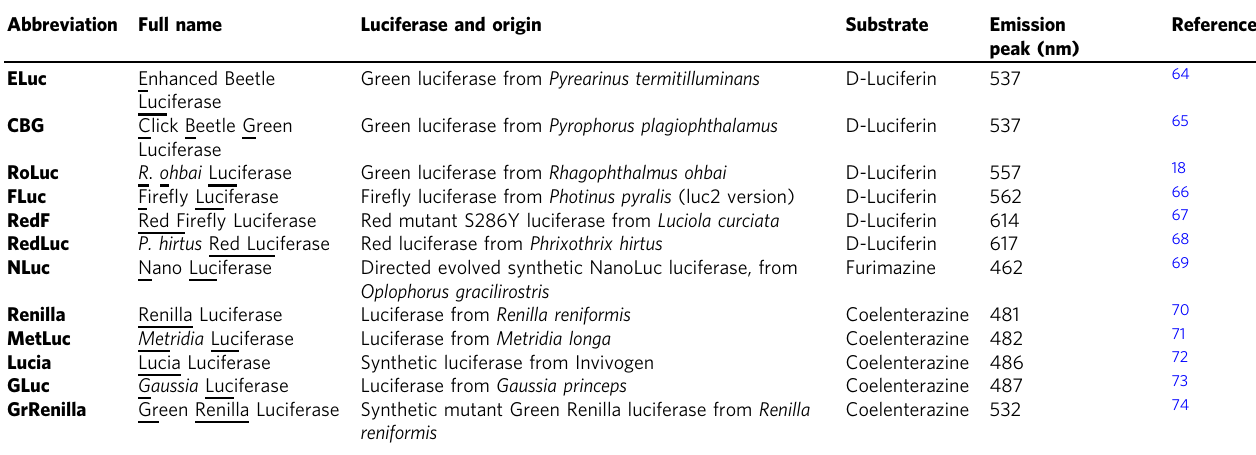
Table 1 List of luciferases evaluated in this